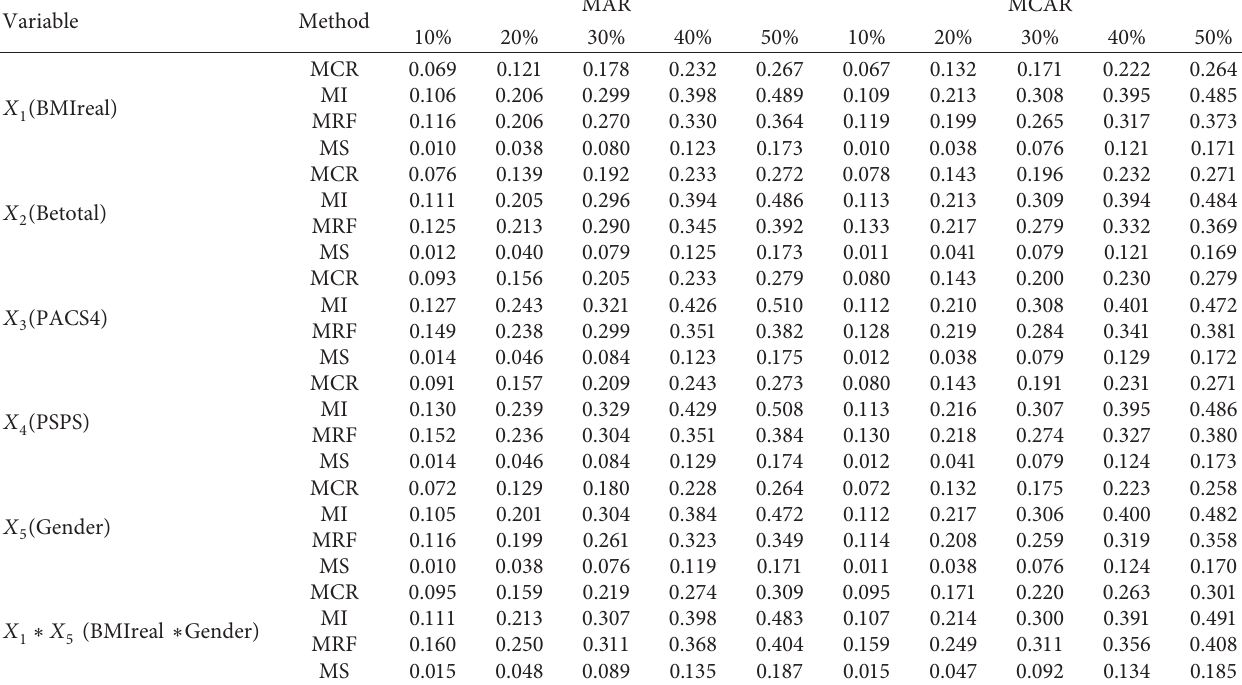
Table 6: Comparison of the performance of imputation methods based on the proportion of the variation attributable to the missing data ( λ ) of regression coefficients over 1000 simulations.